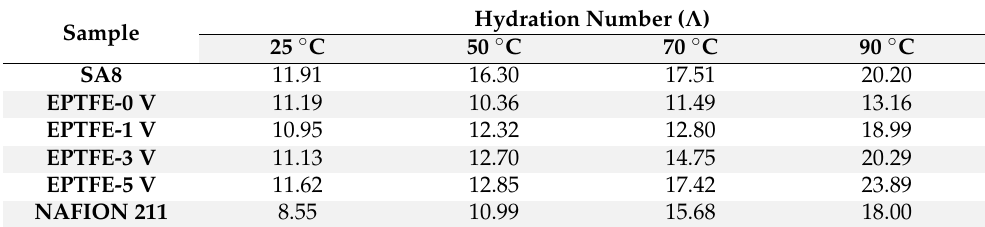
Table 2. λ values of SA8 and ePTFE